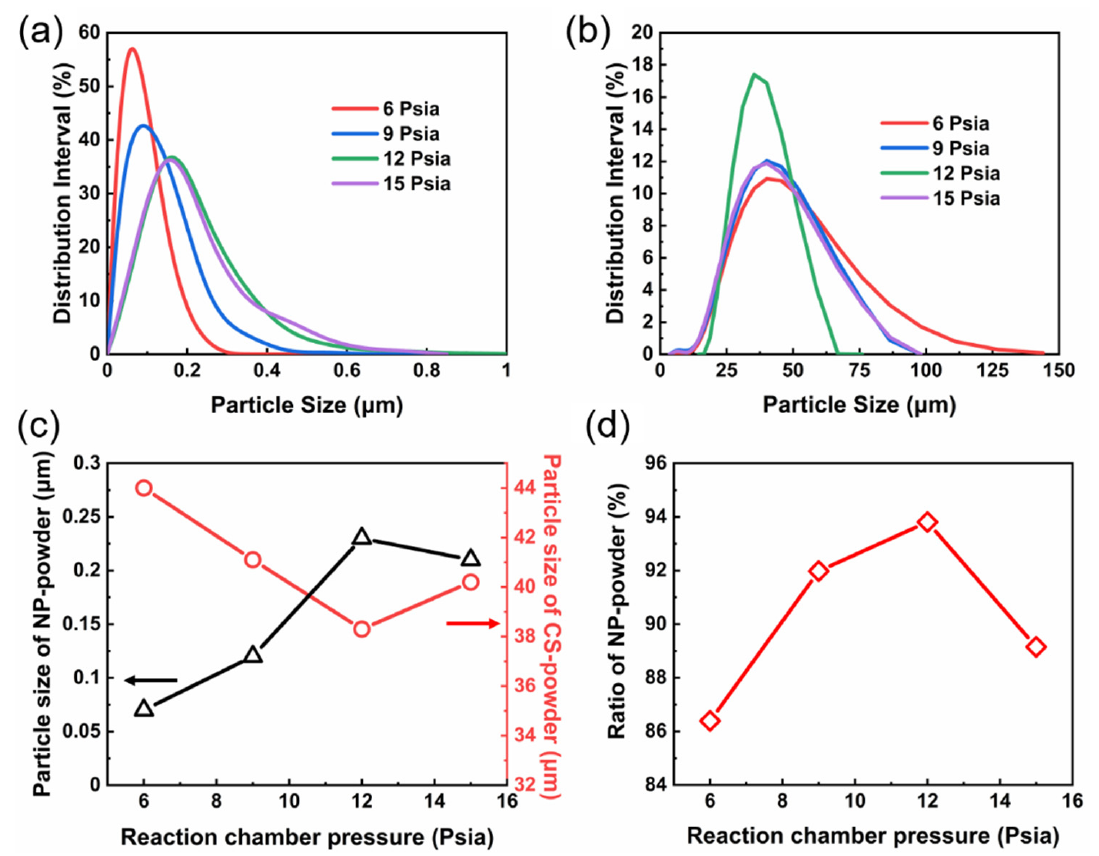
Figure 7. Particle size distribution of the ( a ) NP-powder and ( b ) CS-powder; ( c )average particle size (D 50 ) of the NP-powder and CS-powder, ( d ) ratio of the NP-powder at different reaction pressures.